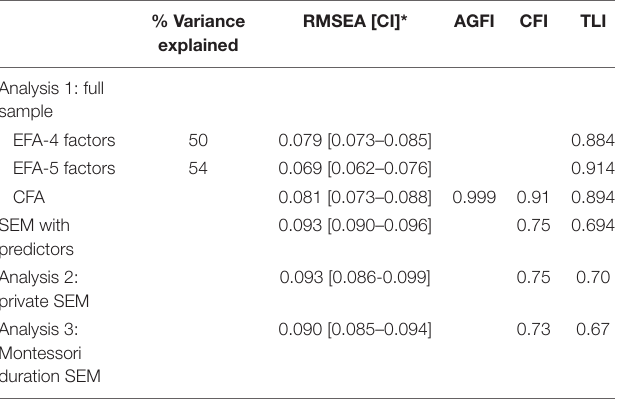
TABLE 2 | Goodness of fit measures and variance explained for analyses 1, 2, and 3. % Variance explained